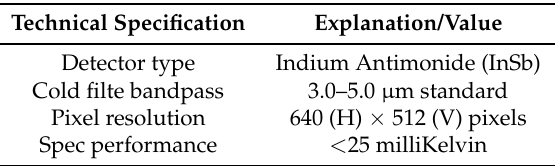
Figure 4. LT and PT configurations: ( a ) schematic set-up for LT; ( b ) schematic set-up for PT (flashes); ( c ) experimental set-up for LT and PT (halogen lamps); ( d ) experimental set-up for PT (flashes). Table 4. Flir Phoenix (MWIR) technical specifications.